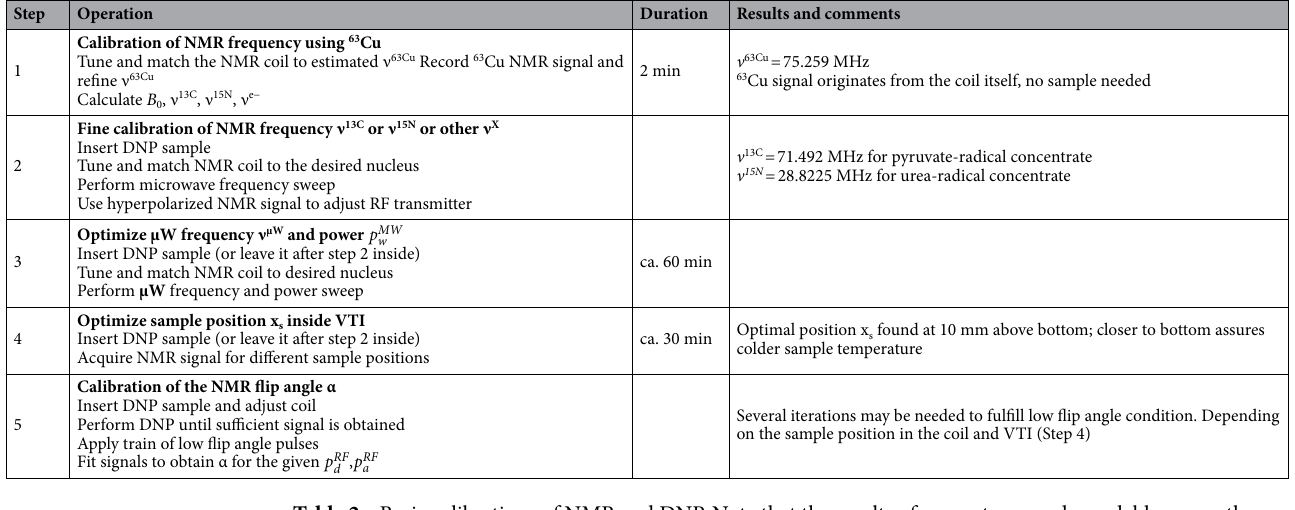
Table 2. Basic calibrations of NMR and DNP. Note that the results of some steps are dependable on another and may need to be repeated (e.g. No.